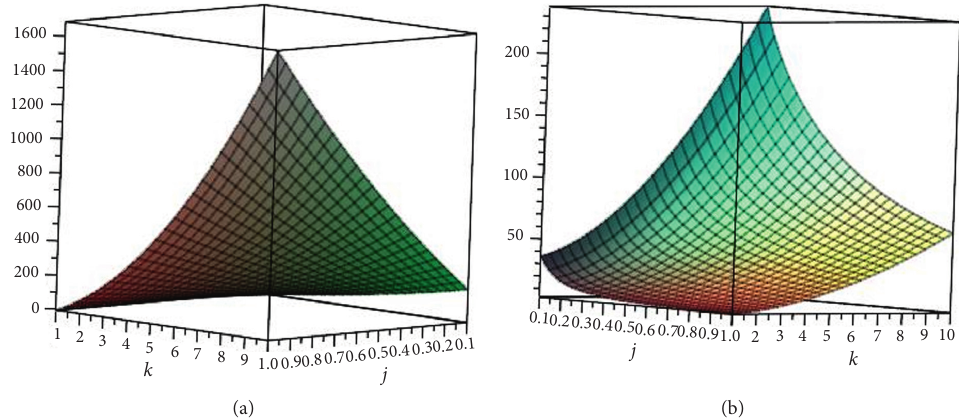
Figure 3: (a) Randic index for j ≤ k and α � 1. (b) Modified second Zagreb index for j ≤ k and α �